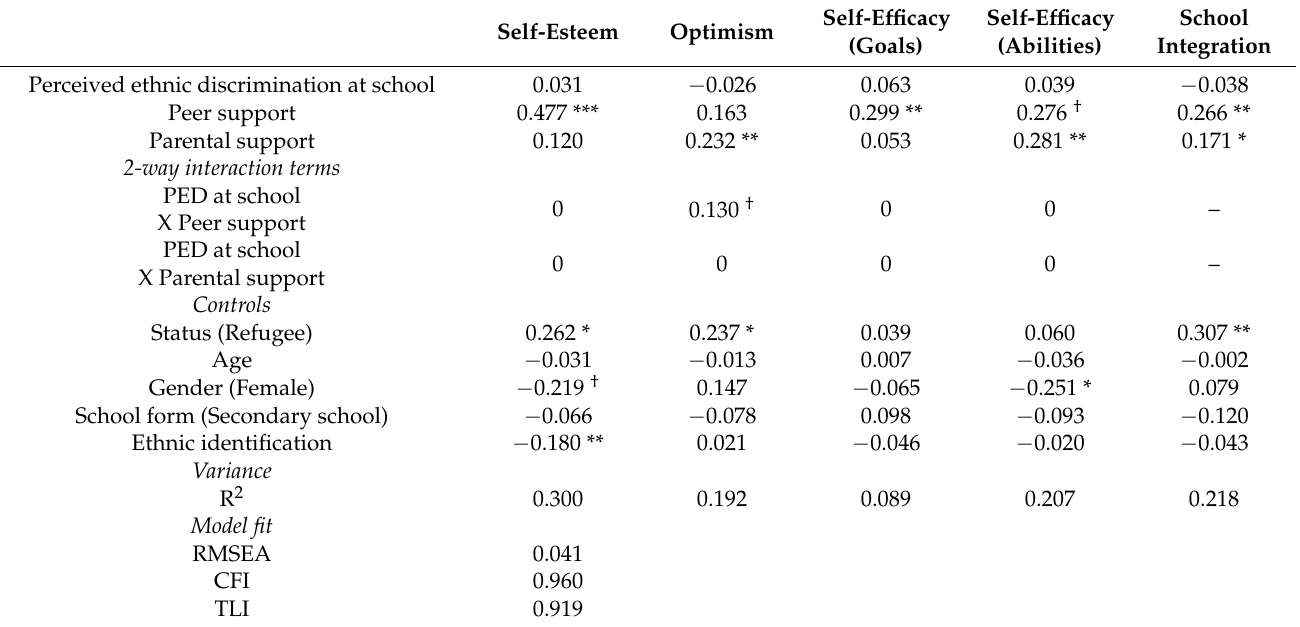
Table 3. Results of the structural equation model ( N =